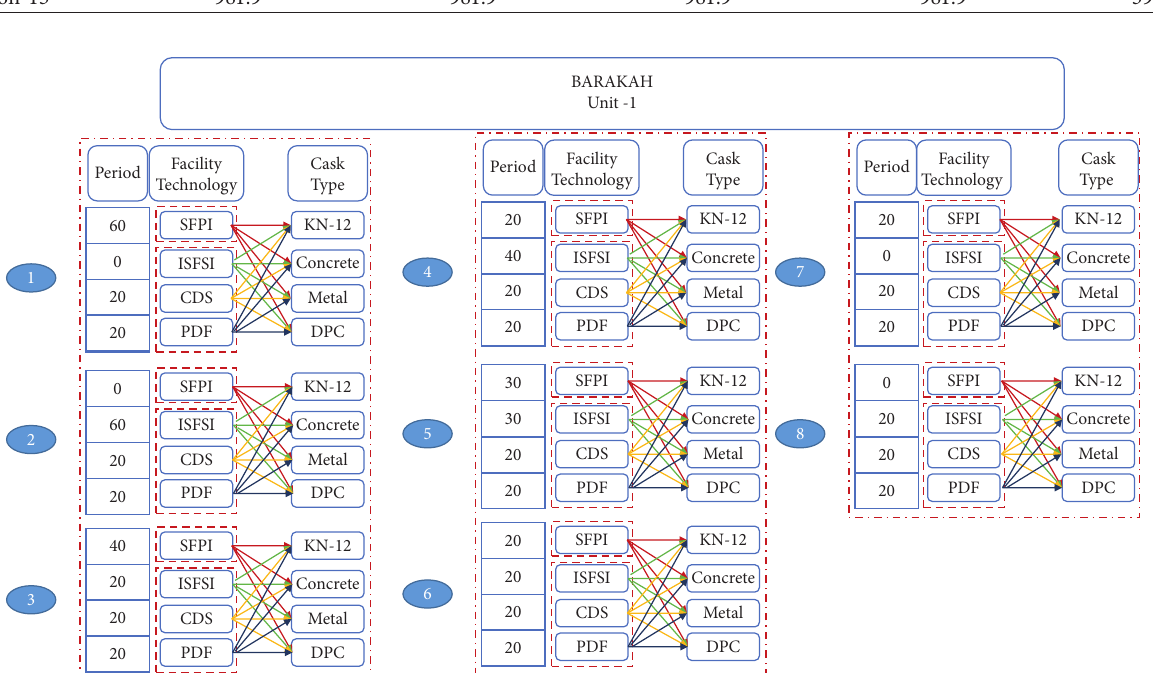
Figure 6: Overall operation-mode scenarios for spent fuel management in Barakah unit